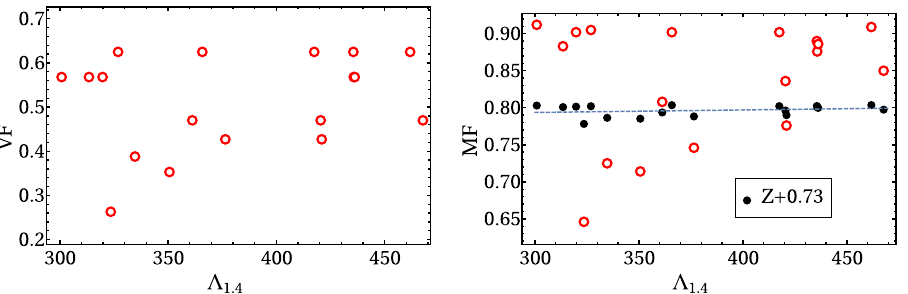
Fig. 5 (Left panel) The plot shows volume fraction V F as a function of the tidal deformability Λ 1 . 4 . (Right panel) The plot of the quark con- tent MF as a function of the tidal deformability Λ 1 . 4 for a 1 . 4 M (cid:8) static star constructed from 18 different EoS in the red hollow dots. The nonlinear relation of the quark content and the tidal deformation